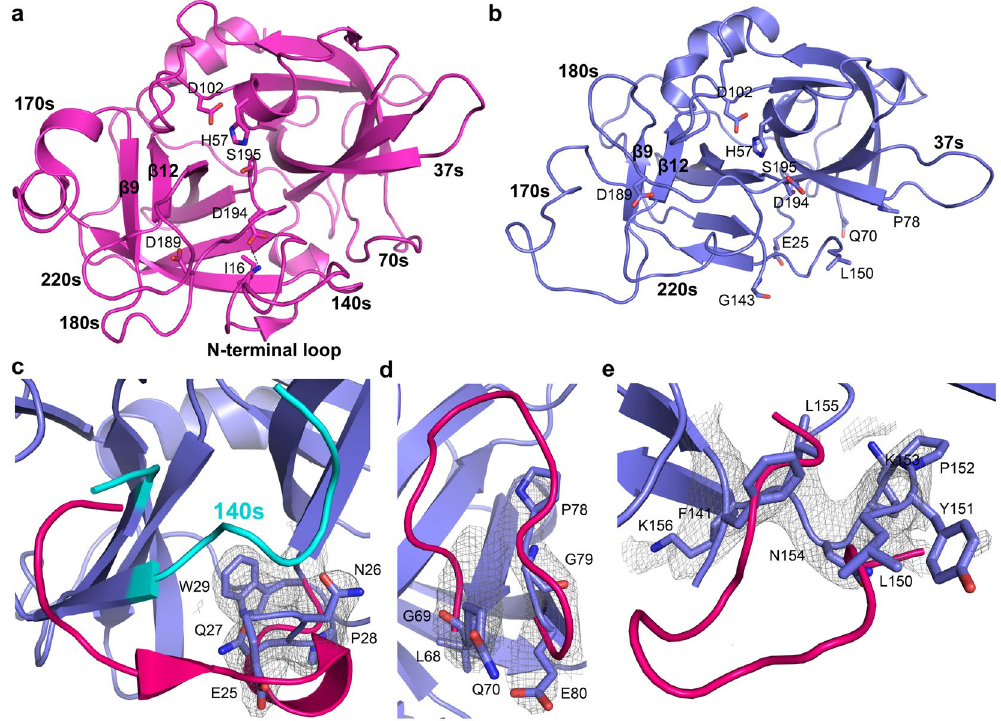
Figure 1. The apo -muPA crystal structure. ( a ) Displays the typical chymotrypsin-like fold as found in the structure of human apo-uPA (PDB ID 4DVA). The catalytic triad (His57, Asp102 and Ser195), the S1 specificity pocket (Asp189) and the activation pocket (Ile16 and Asp194) are shown as sticks. ( b ) Overall structure of apo -muPA. The first defined residues of the missing loop regions in the N-terminal, the 70s and 140s loops are shown as sticks. ( c , d and e ) Indicates the missing loop regions in apo -muPA by superposition of the structure around ( c ) the N-terminal loop, ( d ) the 70s loop and ( e ) the 140s loop with the 2 F o – F c electron density map (grey mesh) at contour level σ = 1. The backbone trace of the corresponding loops in human apo -uPA is represented as cartoon